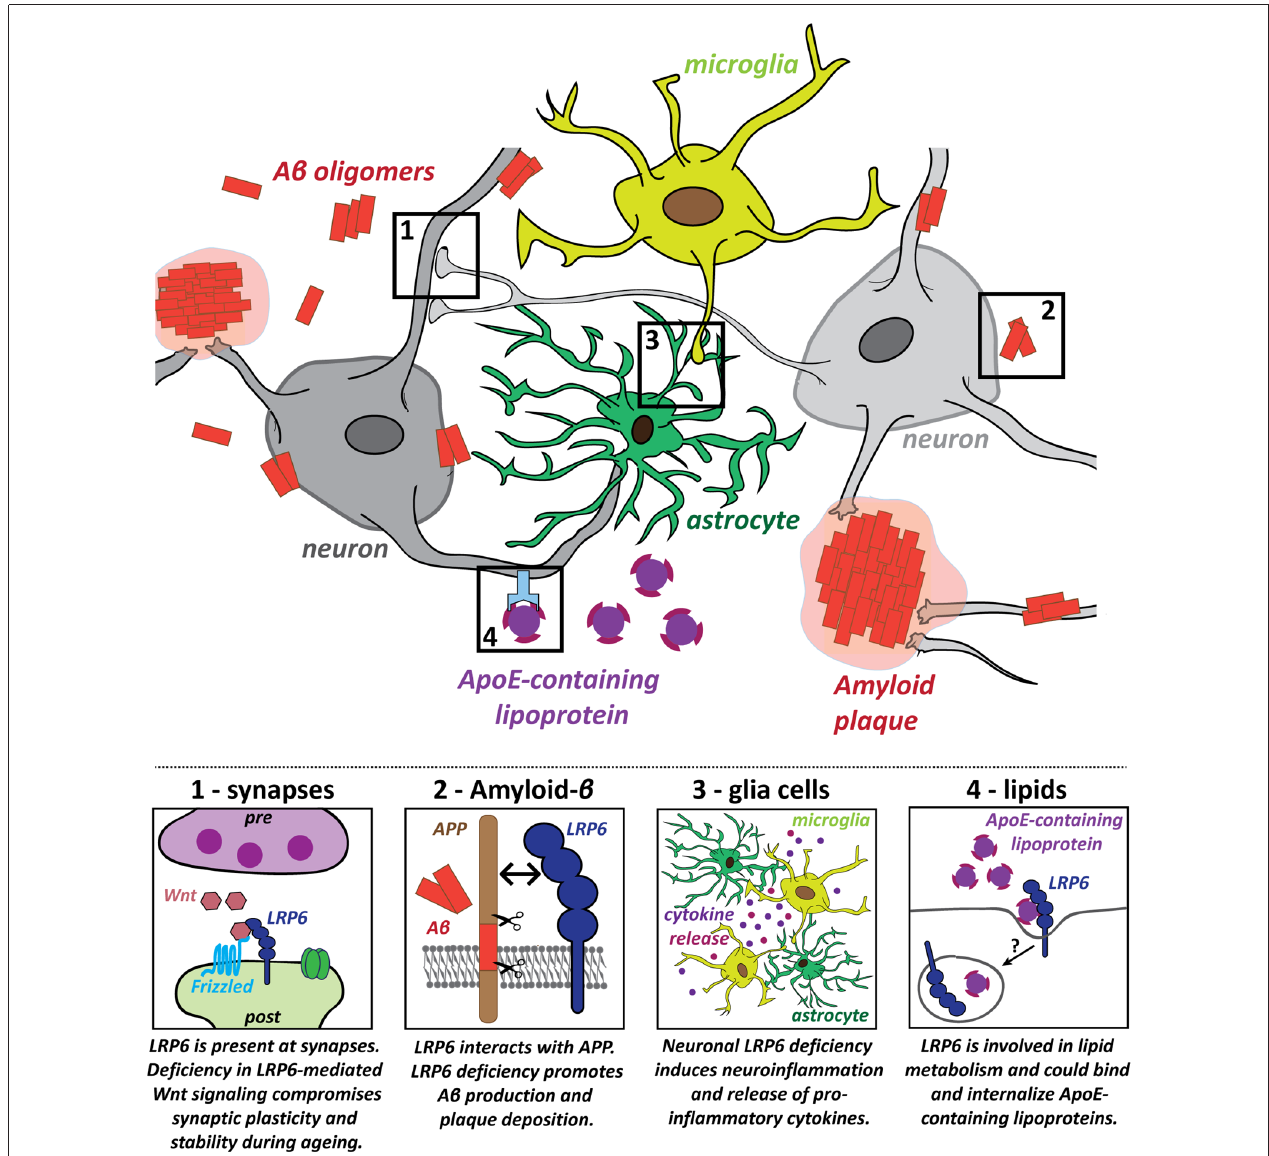
FIGURE 2 | Potential roles for the LRP6 receptor in several key pathogenic processes in Alzheimer’s disease (AD). Several hallmarks of AD pathology have been identified and LRP6 dysfunction contributes to these pathogenic processes in multiple different ways: (1) Deficiency in LRP6-mediated Wnt signaling increases synaptic vulnerability, which could promote synaptic dysfunction and loss in AD; (2) LRP6 regulates amyloid precursor protein (APP) processing and LRP6 loss of function increases amyloid- β (A β ) generation and plaque formation; (3) Neuroinflammatory processes also contribute to AD pathology. Neuronal LRP6 deficiency has a secondary impact on microglia and astrocytes, promoting neuroinflammation and secretion of pro-inflammatory molecules; (4) Lipid metabolism is deregulated in AD and Apolipoprotein E ( ApoE ) is a major genetic risk factor for AD. LRP6 could participate in cholesterol transport and may be involved in the internalization of ApoE-containing lipoprotein